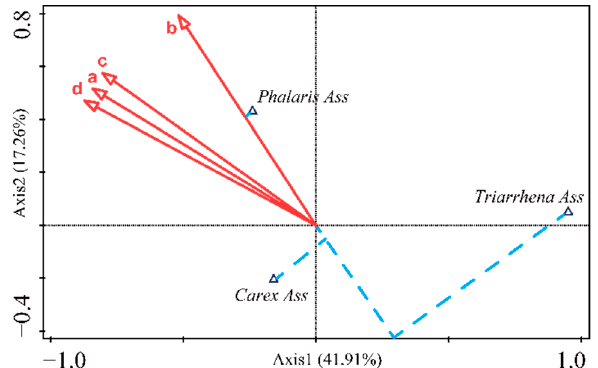
Figure 6. Biplot of the final CCA showing the distribution of three vegetation communities along the gradient of the four hydrological indicators in the study area. a—Annual average inundation days (d), b—Average inundation days per inundation (d), c—Annual average inundation depth (m), and d—Annual maximum inundation depth (m).